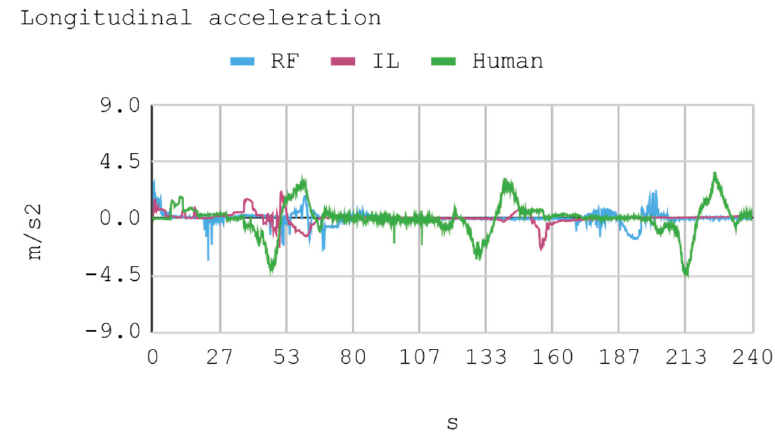
Figure 9. Case 1. Lateral and longitudinal acceleration of the automobile.